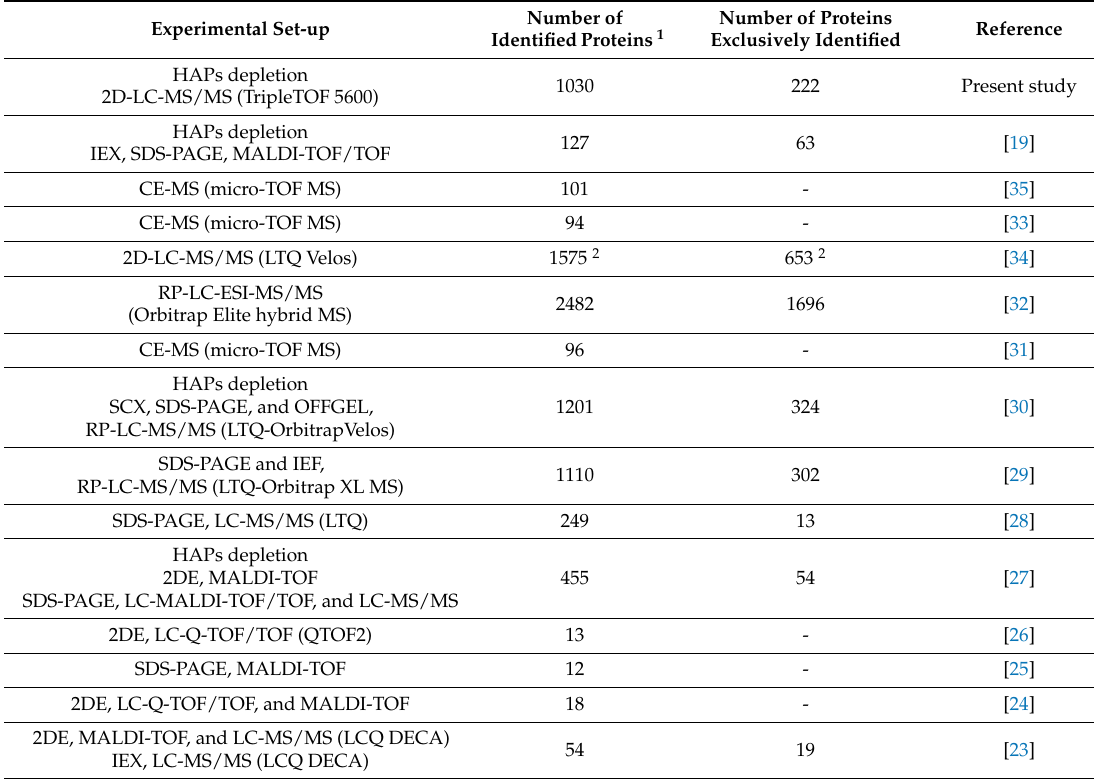
Table 3. Comparison of proteins identified in vitreous using different experimental set-ups. Experimental